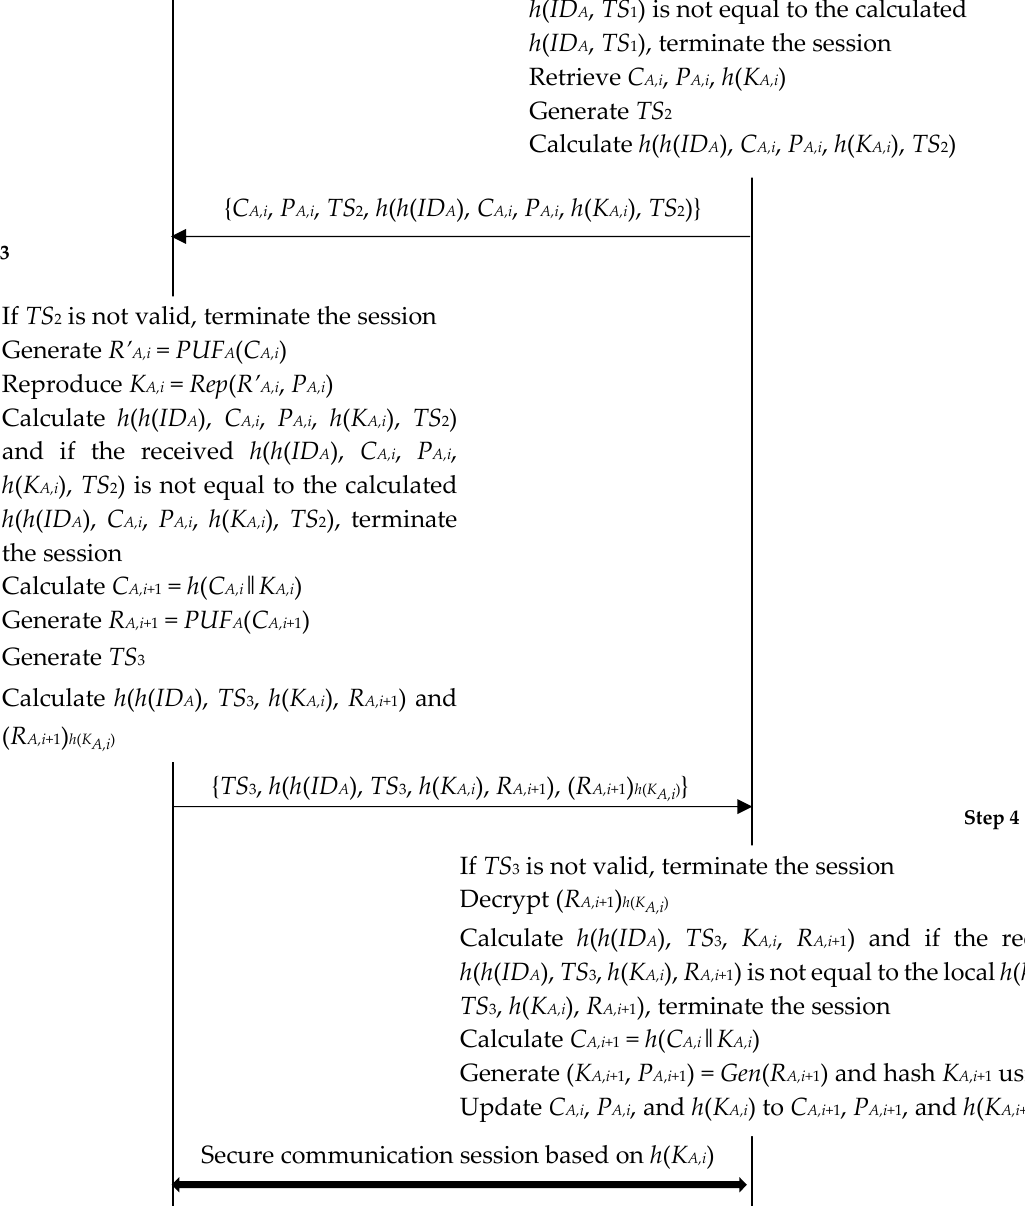
Figure 5. Mutual authentication and key update phase.